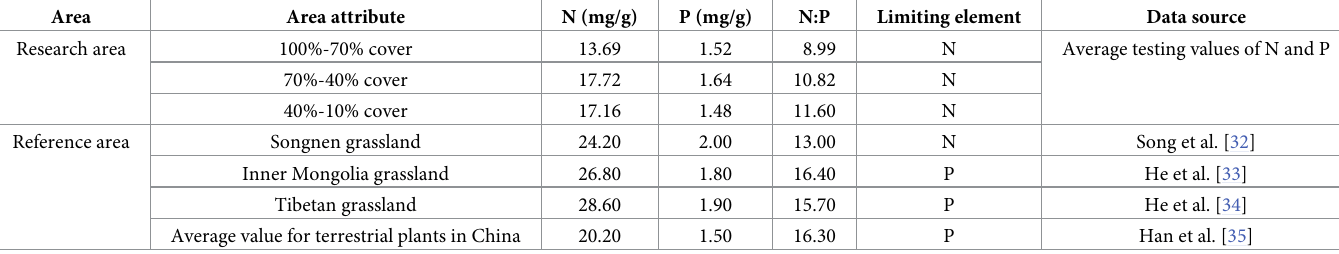
Table 2. N and P contents, N: P ratios and growth-limiting elements in the aboveground parts of plants collected from the study area and the reference areas. Area Area attribute N (mg/g) P (mg/g) N:P Limiting element Data source Research area 100%-70% cover 13.69 1.52 8.99 N Average testing values of N and P 70%-40% cover 17.72 N 40%-10% cover 17.16 1.48 N Reference area Songnen grassland 24.20 2.00 13.00 N Song et al. [32] Inner Mongolia grassland 26.80 1.80 16.40 P He et al. [33] Tibetan grassland 28.60 1.90 15.70 P He et al. [34] Average value for terrestrial plants in China 20.20 1.50 16.30 P Han et al.